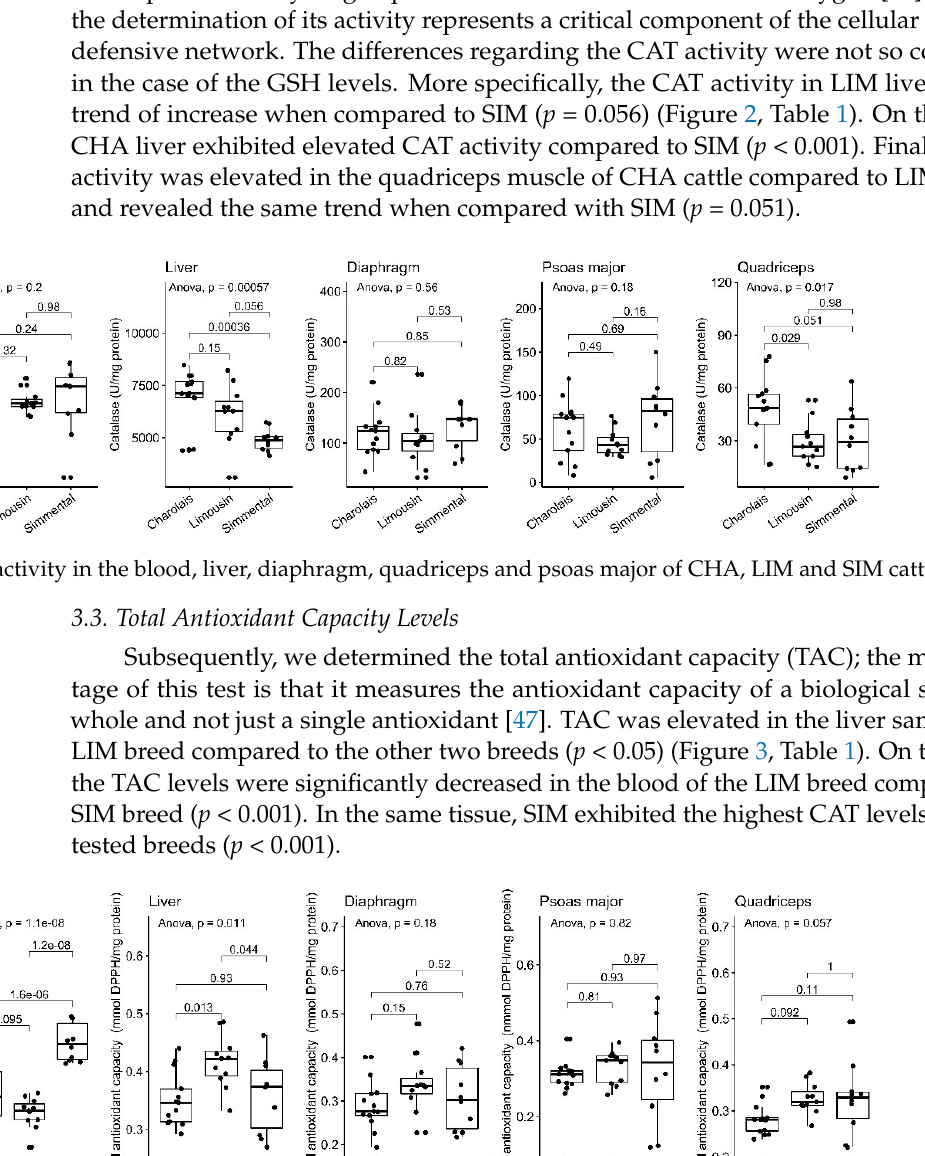
Figure 1. GSH levels in the blood, liver, diaphragm, quadriceps and psoas major of CHA, LIM and SIM cattle.